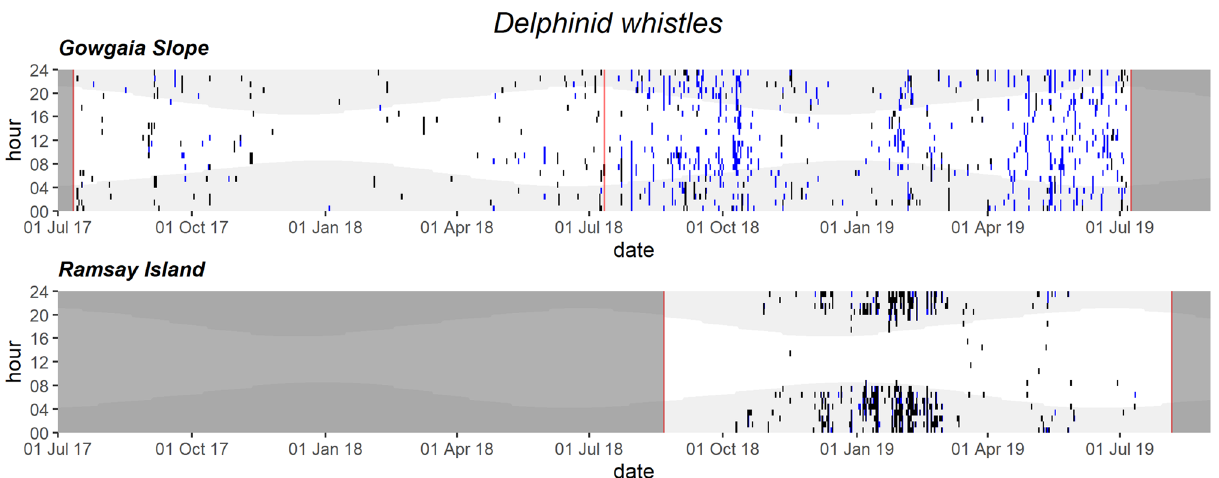
Figure 11. Daily and hourly occurrence of delphinid whistles at Gowgaia Slope and Ramsay Island in 1-h bins. Blue dots indicate automated detections. Black dots indicate confirmed occurrence. Red lines indicate recorder deployment and retrieval dates. Dark grey areas indicate a lack of recordings. Light grey shaded areas indicate hours of